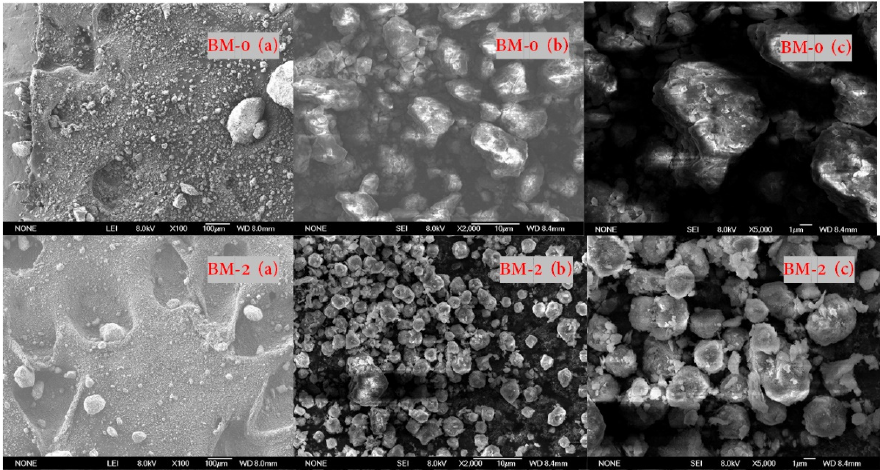
Figure 6. Charts of SEM of BM-0 and BM-2. ( a ) Size of 100 μ m; ( b ) Size of 10 μ m; ( c ) Size of 1 μ